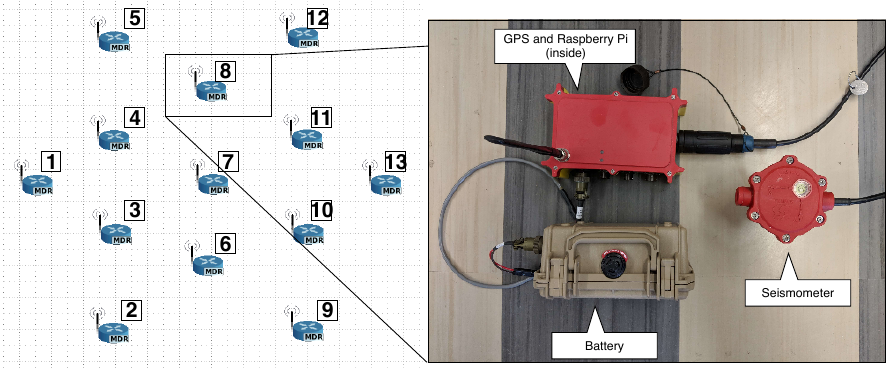
Figure 16. Deployment topology and smart seismic sensor